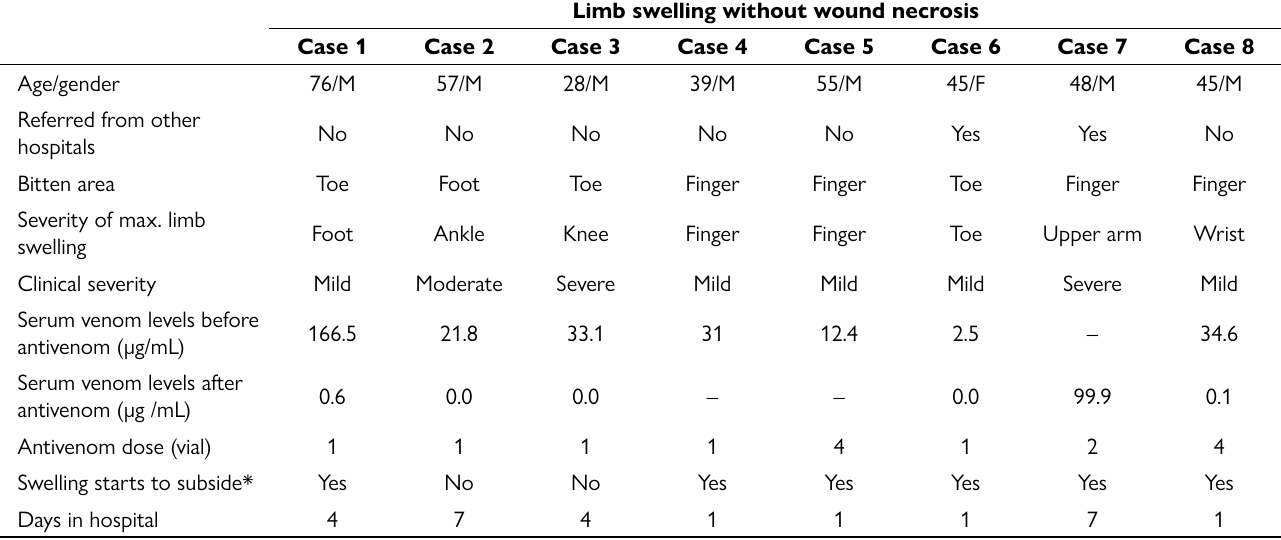
*Swelling starts to subside 12 hours after antivenom